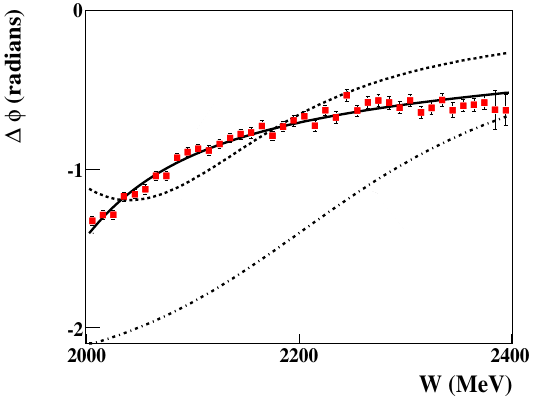
Fig. 9 Phase motion of the partial wave fit to the γp → pω differential cross section and spin density matrix elements. 3 resonant states, the subthreshold resonance N (1680) 5 2+ , − , and the missing N (2000) 5 2+ are needed to fit N (2190) 7 2 the data (solid line). Fits without N (2000) 5 2+ (dashed-dotted line), or without N (1680) 5 2+ (dashed line) cannot reproduce the data.